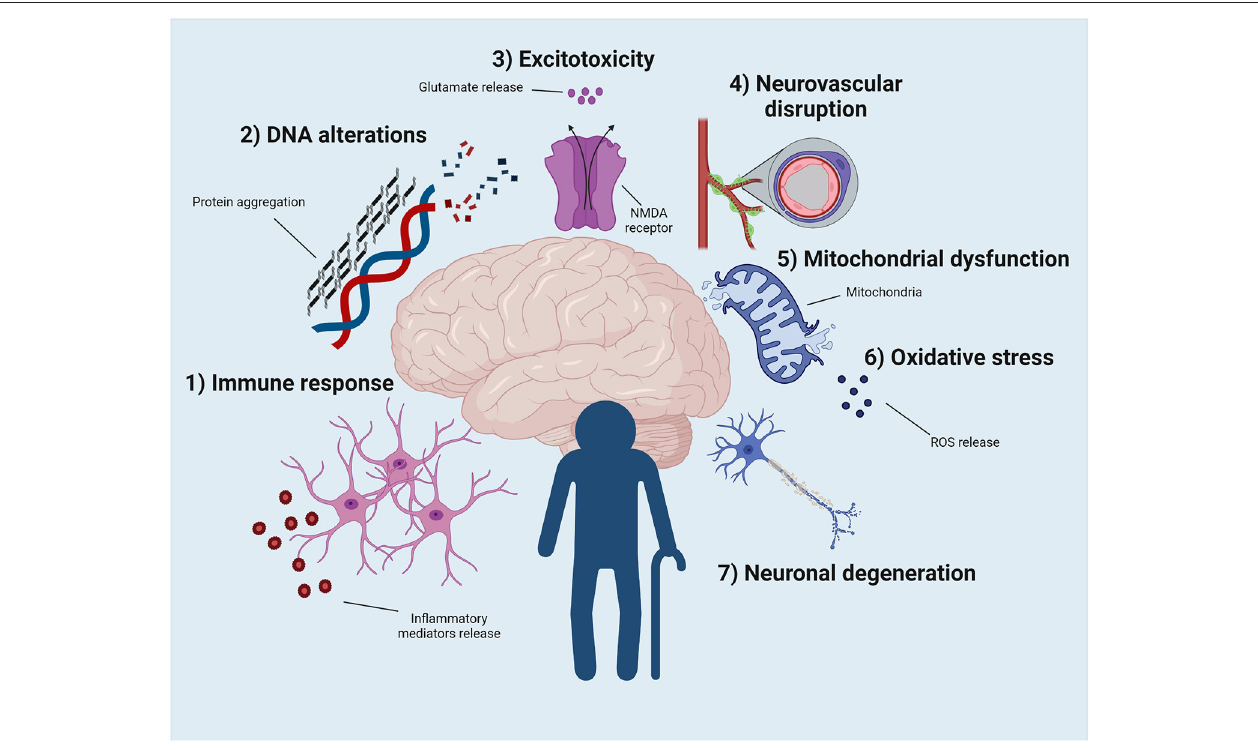
FIGURE 1 | Potential physiological events that can contribute to the development of epilepsy and to the better pharmacological response of older people with epilepsy. (1) The exacerbated immune response, as well as the change in the phenotype and properties of microglia and astrocytes, seem to contribute to this phenomenon. (2) DNA modification due to protein aggregation contributes to enhance epilepsy vulnerability in the elderly population. (3) The uncontrolled release of glutamate ultimately leads to increased excitotoxicity, resulting in a new pathway that explains old brain function. (4) Blood-brain barrier permeability increases with aging. This event may increase the vulnerability to developing epilepsy but may also improve pharmacological sensitivity in older adults. (5) Mitochondrial dysfunction and oxidative stress (6) can be related to epilepsy, age, and drug response. (7) Neuronal death secondary to aging increases the susceptibility to epilepsy. Illustration created with BioRender.com under a paid